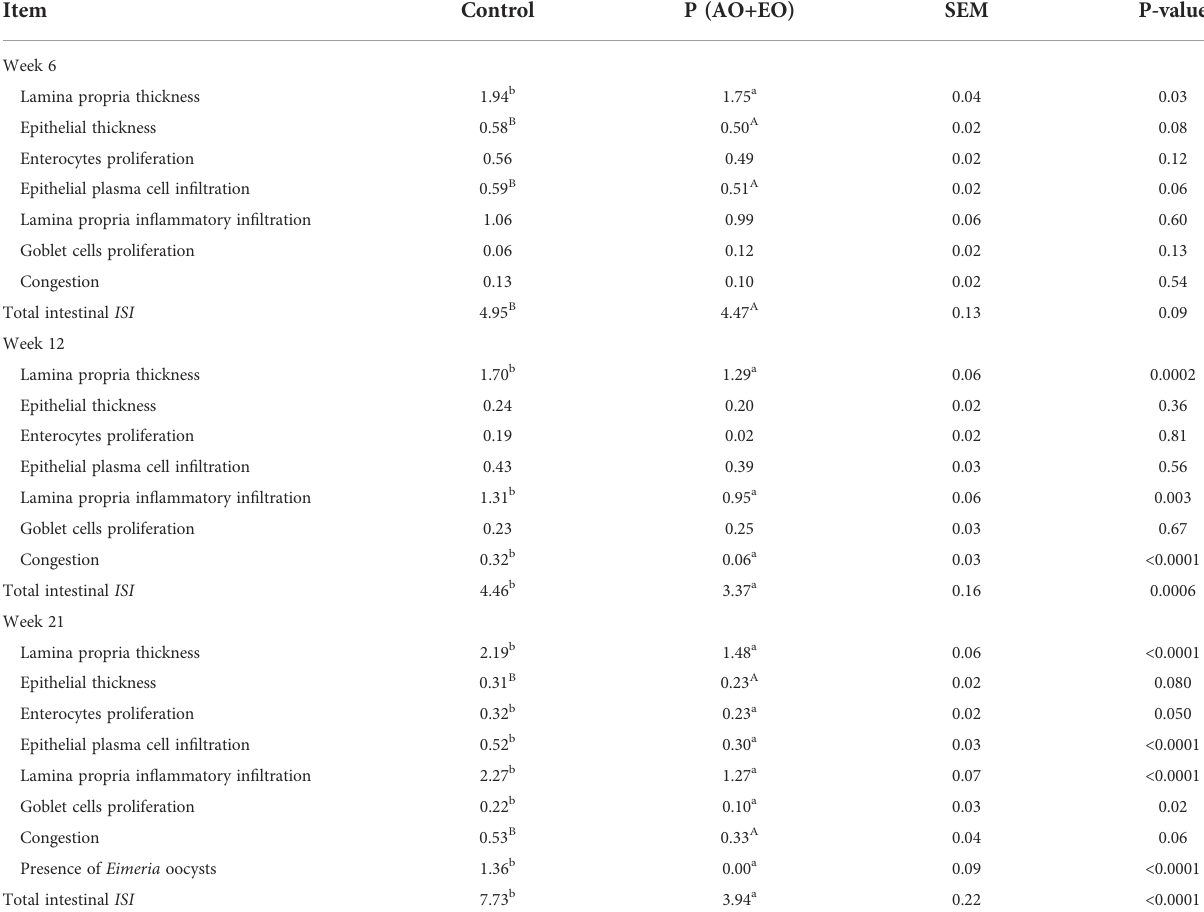
TABLE 4 Histologic intestinal health – ISI score at 6, 12, and 21 weeks of age.